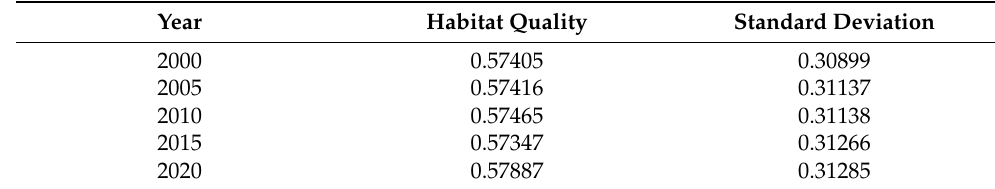
Table 9. Habitat quality of the Yellow River Basin in 2000, 2005, 2010, 2015, and